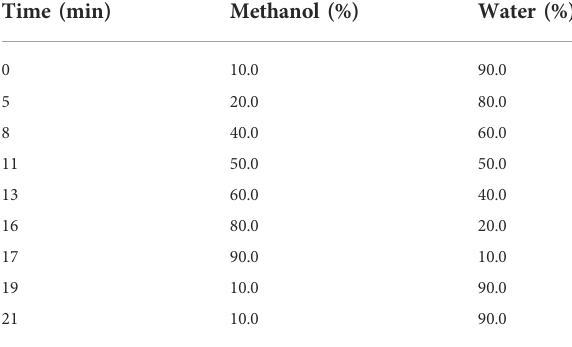
TABLE 1 Chromatographic gradient conditions for the analysis of O. Syriacum ethanolic crude extract. Time